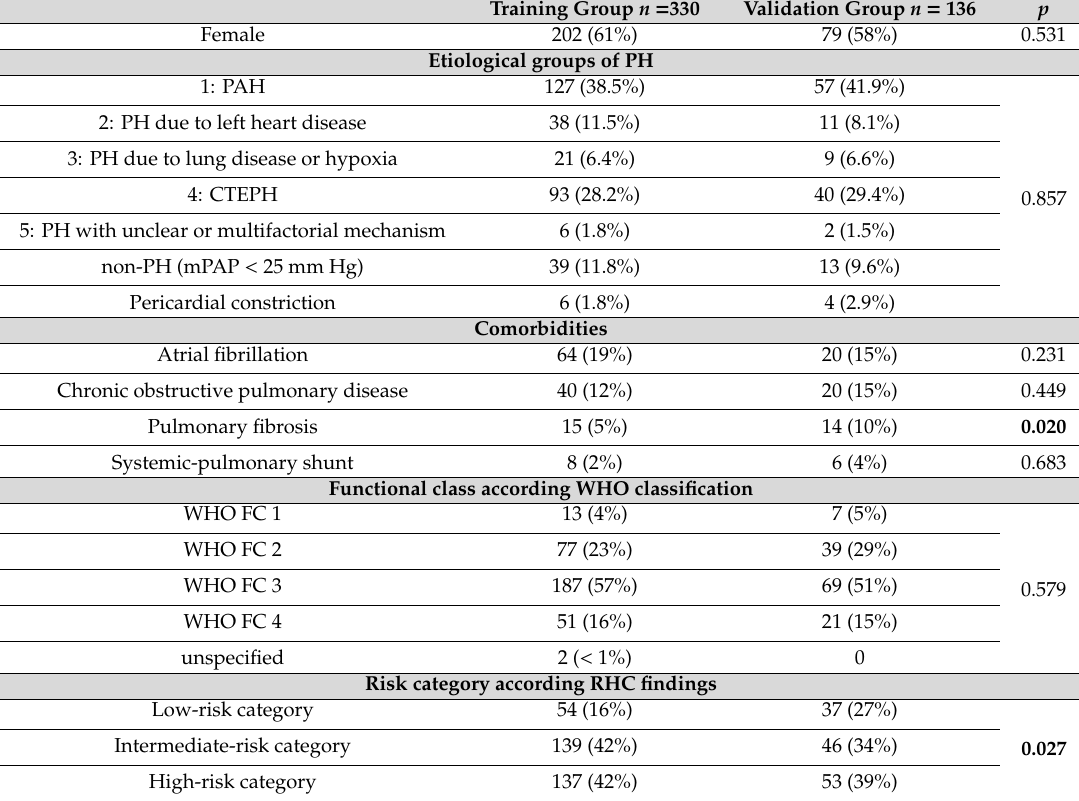
Table 2. Baseline characteristics—discrete variables (number,